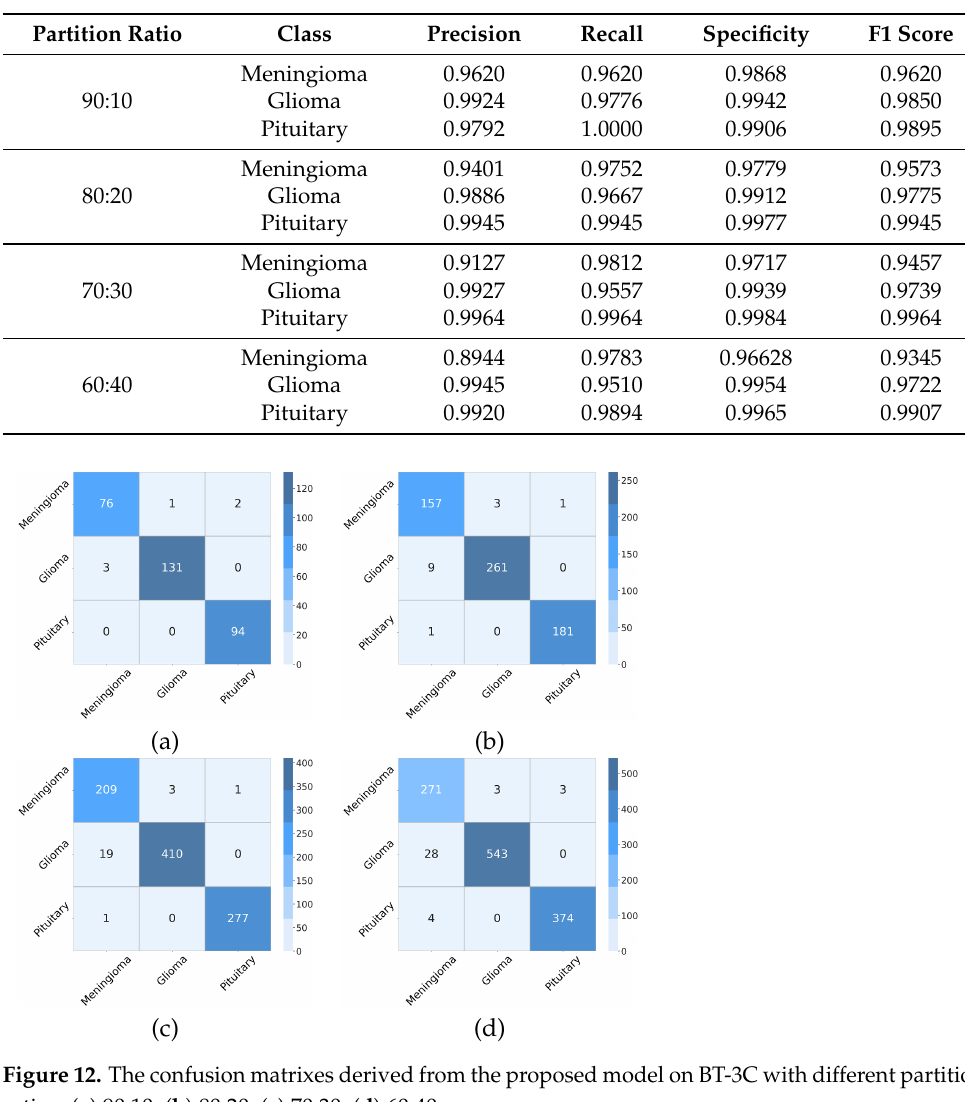
Table 8. Classification performance of the proposed method on dataset BT-3C.